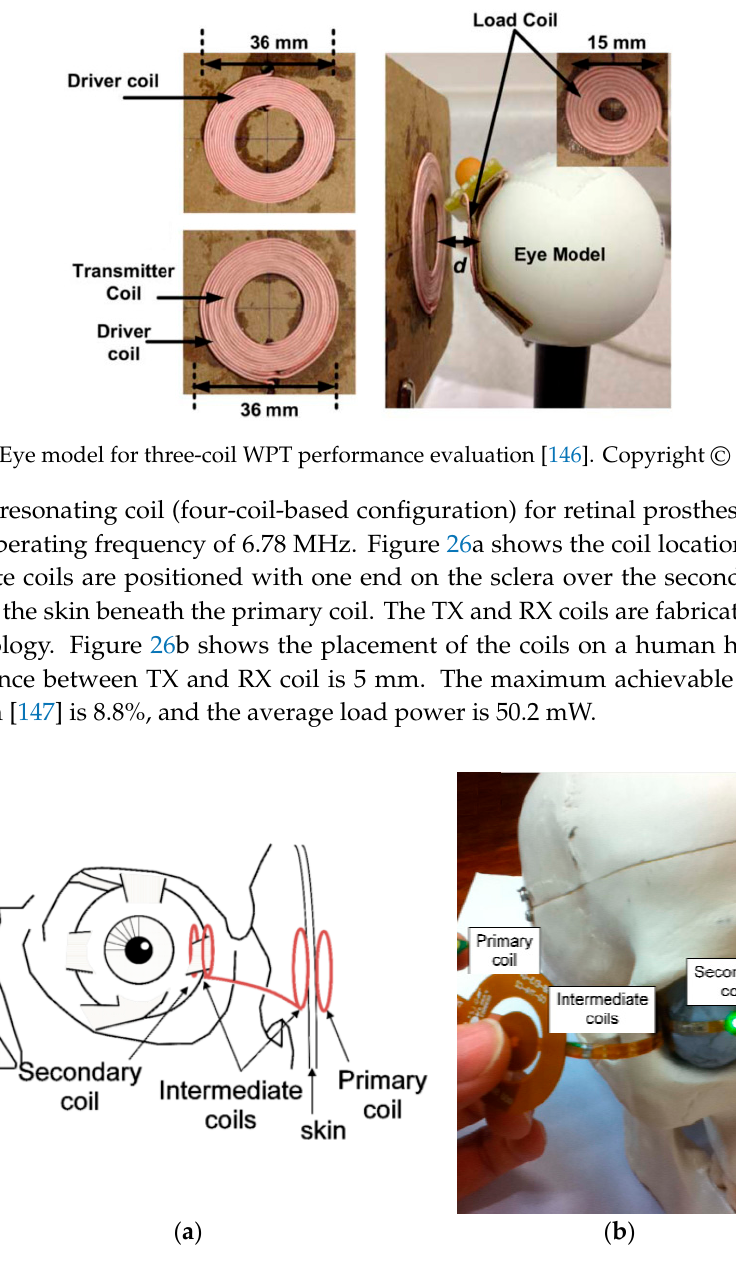
Figure 24. The three-coil link test setup, including a sheep brain and skull [145]. Copyright © 2017, IEEE.